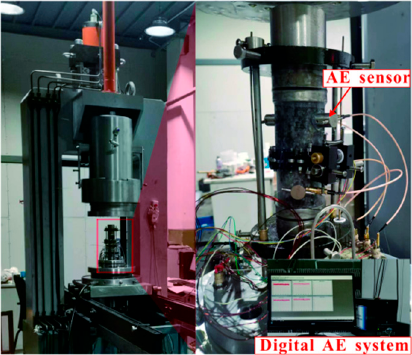
Figure 2. Loading and unloading test system.